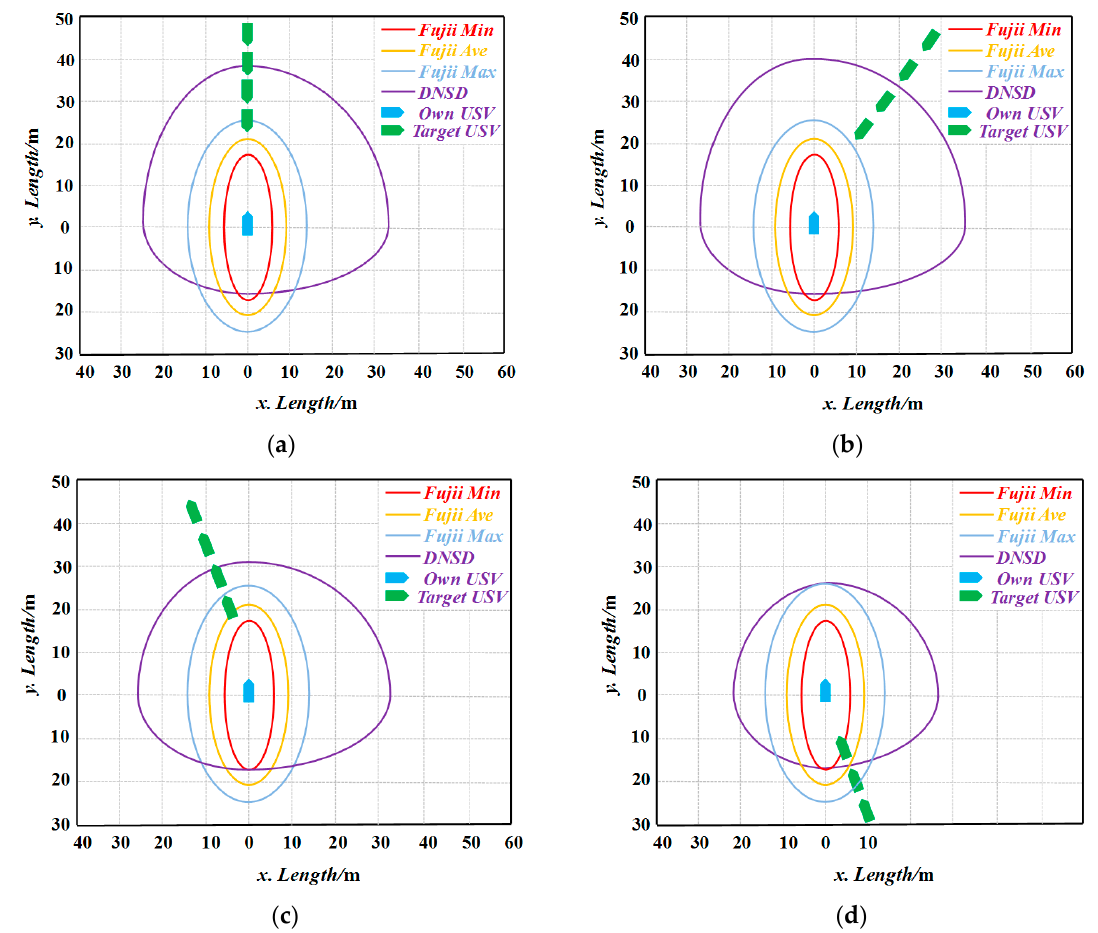
Figure 14. The DNSD compared with the Fujii model in various encounter situations: ( a ) Head-on; ( b ) Crossing; ( c ) Overtaking; ( d ) Overtaken.